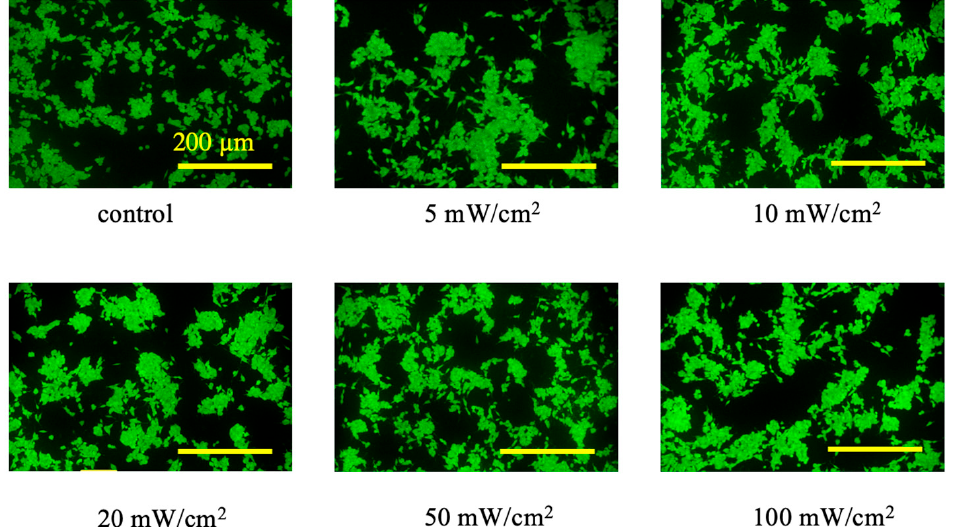
Figure 5. ROS of control and CW light groups with different power densities, showing an interesting triphasic pattern.